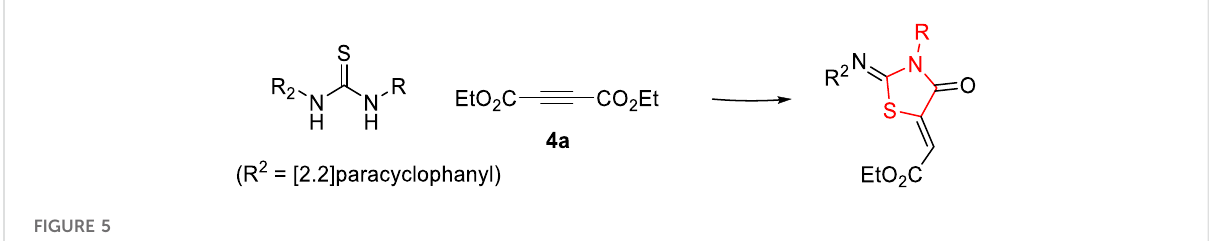
FIGURE 5 Stereochemistry of 5a-l .